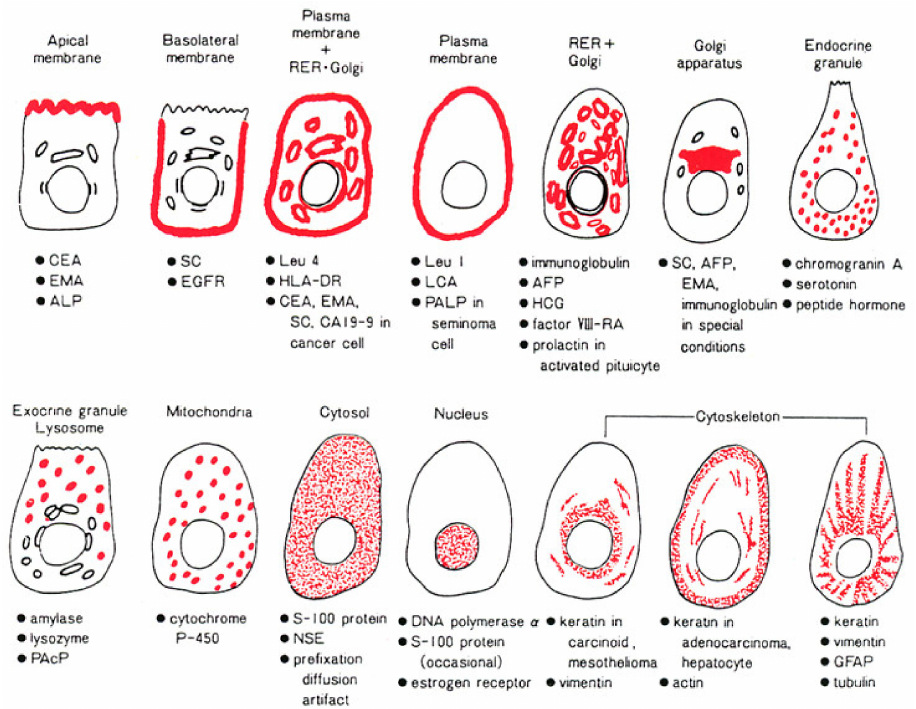
Figure 44. Schematic illustration of intracellular localization of antigens. The specificity of immunos- taining can be judged by the intracellular localization pattern of the antigenic substances as either membranous, diffuse cytoplasmic, granular/vesicular cytoplasmic or nuclear. Peptide hormones and chromogranin A are localized as intracytoplasmic fine gran- ules, but lysosomal and mitochondrial proteins are visualized as intracytoplasmic coarse granules. Secretory proteins such as alpha-fetoprotein, human chorionic gonadotropin, and immunoglobulins, which are seen as fine or coarse vesicles in the cytoplasm, represent ultrastructural localization in the rough endoplasmic reticulum and Golgi apparatus. Par- ticularly in neoplastic cells, the immunoreactivity of secretory proteins may be accentuated and clustered in the Golgi area. Diffuse cytoplasmic reactivity is seen for cytosolic proteins such as myoglobin, NSE, creatine kinase-MM isozyme and GST. S-100 protein, heat-shock proteins, ubiquitin, and β -catenin are distributed diffusely in both the cytoplasm and nucleus. The nuclei are diffusely positive for Ki-67 (MIB-1), p53, CDX2, ER, and PgR, but nucleolar staining is frequently accentuated for Ki-67. Plasma membrane proteins reveal distinct membrane staining, and the Golgi area is also frequently positive. Carcinoem- bryonic antigen (CEA) is expressed along the apical plasma membrane in normal gastric and colonic mucosa, whereas in adenocarcinomas of the stomach and colon, the plasma membranes are circumferentially positive [78]. Such intracellular antigen distribution patterns are clearly recognized in FFPE sections when compared with fresh-frozen